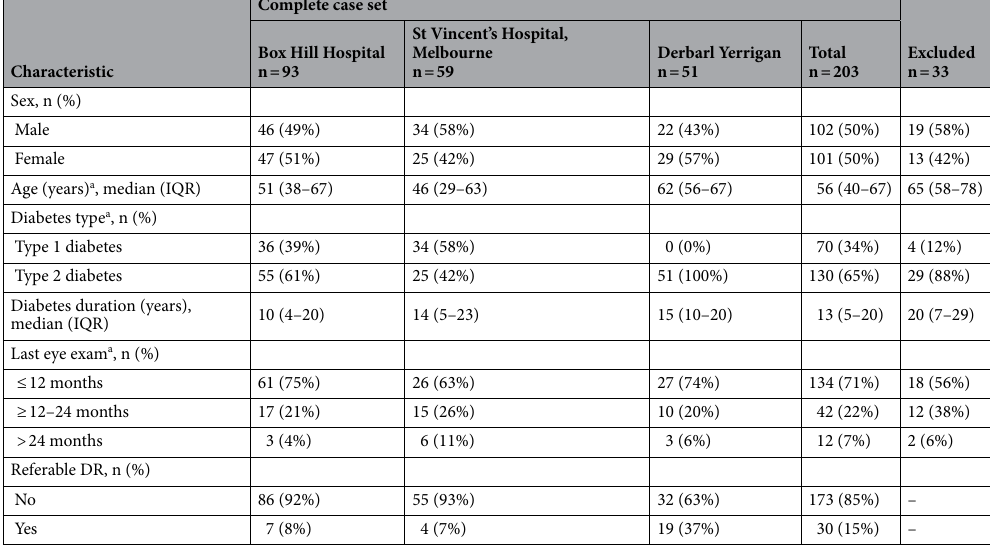
Table 1. Characteristics of participants included and excluded from primary analysis. IQR = interquartile range; DR = diabetic retinopathy. a Missing data for age (n = 1 included, n = 2 excluded), diabetes type (n = 2 included), time since last eye exam (n = 15 included, n = 1 excluded).